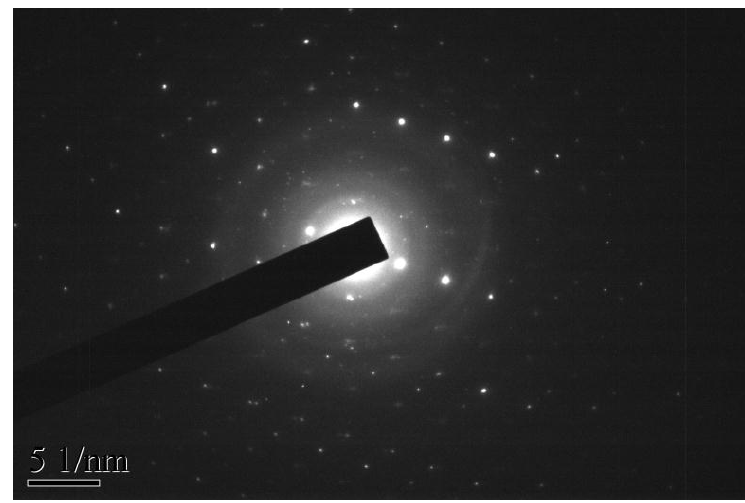
Figure 3. The selected area electron diffraction pattern of ZnBiErO 4 .